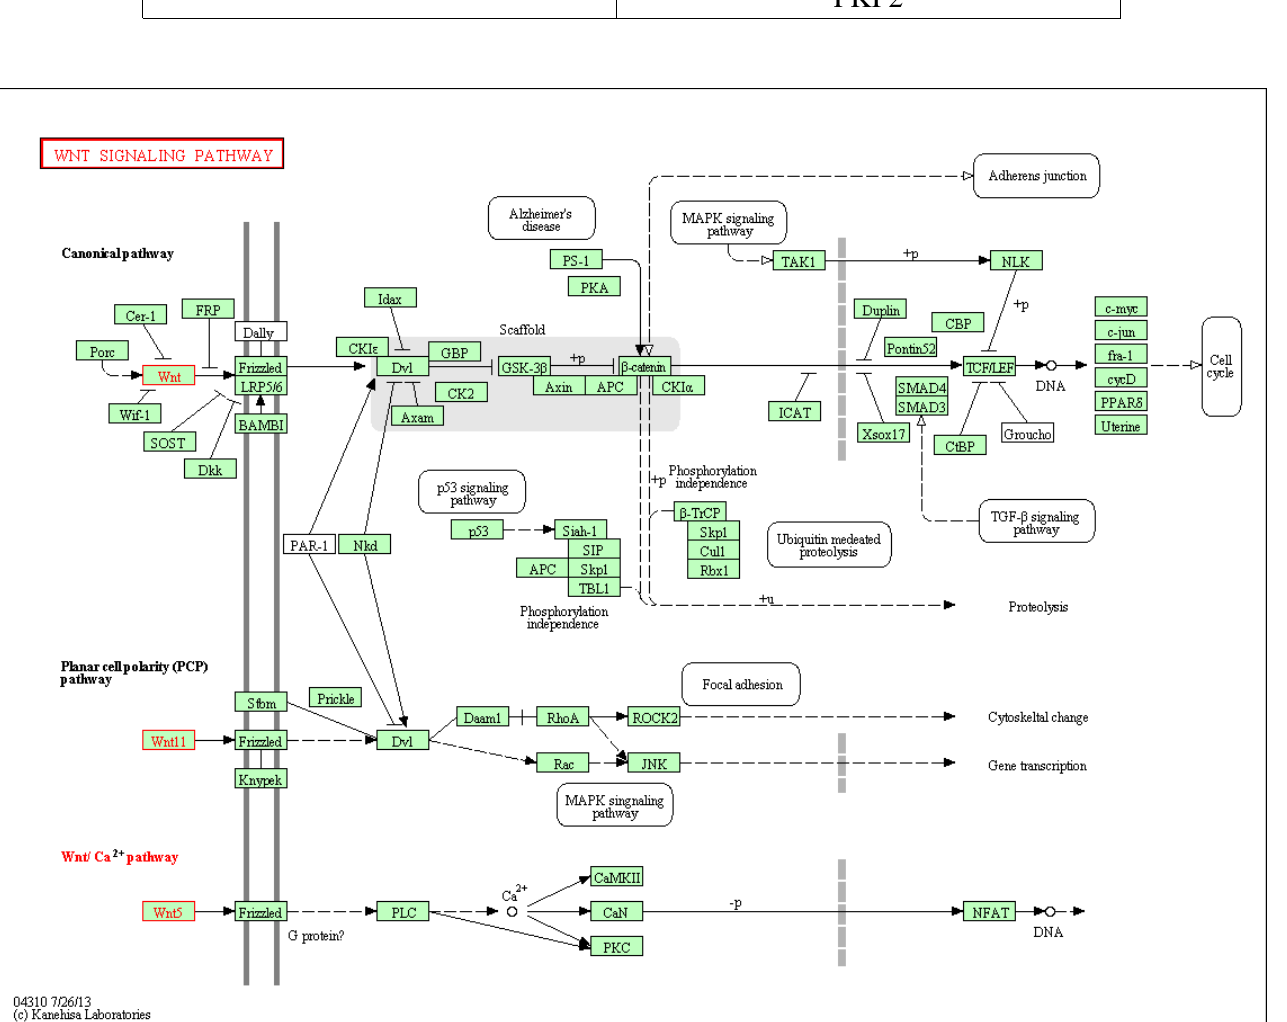
Figure 5: Resulting WNT Signaling Pathway [29,